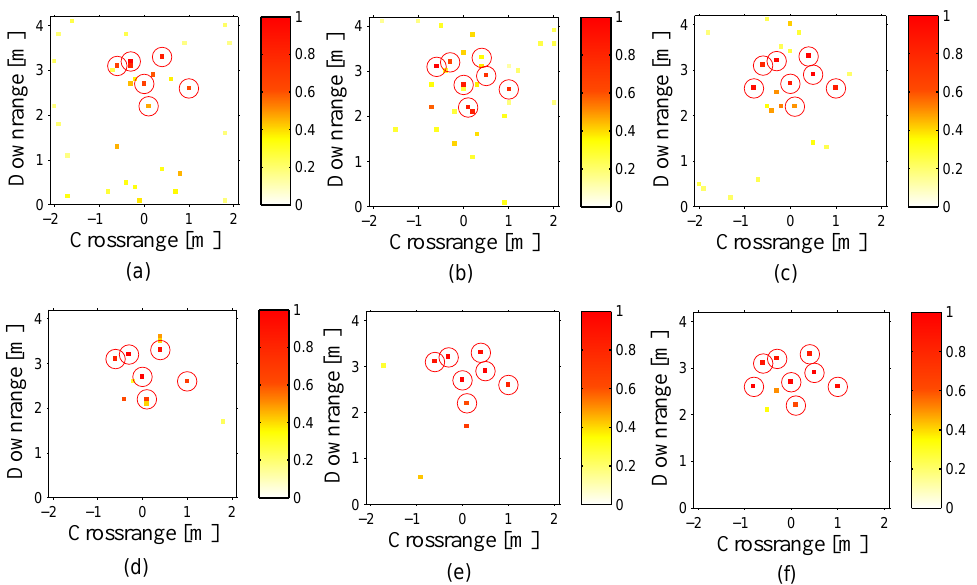
Figure 3. Comparison of targets’ reconstruction by conventional CS and interaction CS with different numbers of targets. ( a , d ) for 6 targets; ( b , e ) for 7 targets; and ( c , f ) for 8 targets; ( a – c ) for conventional CS; and ( d – f ) for interaction CS. All the front wall clutters are removed.